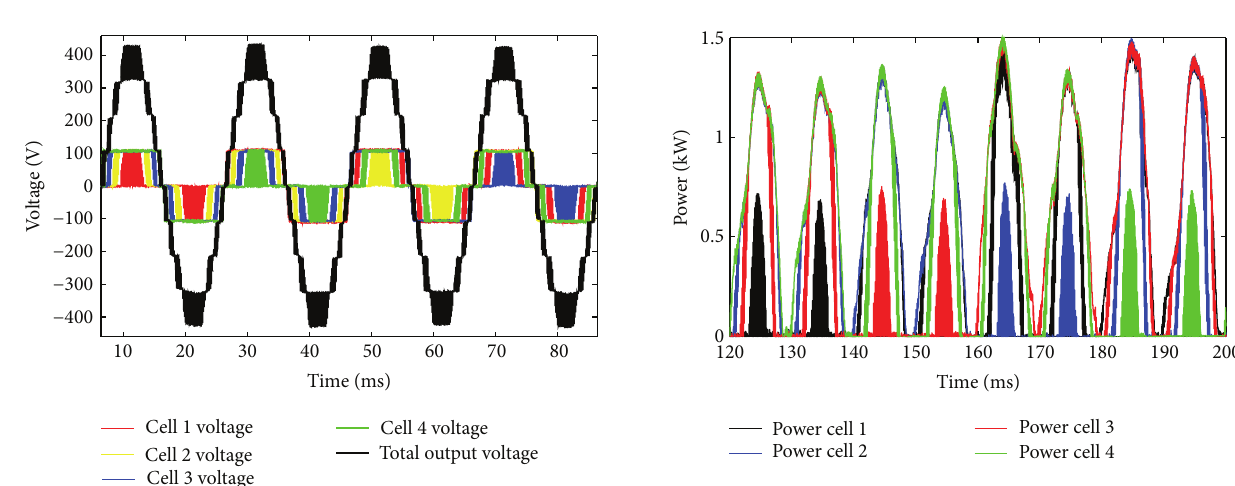
Figure 12: The order of the cell voltages is rotated once per cycle, with the output voltage unaffected.